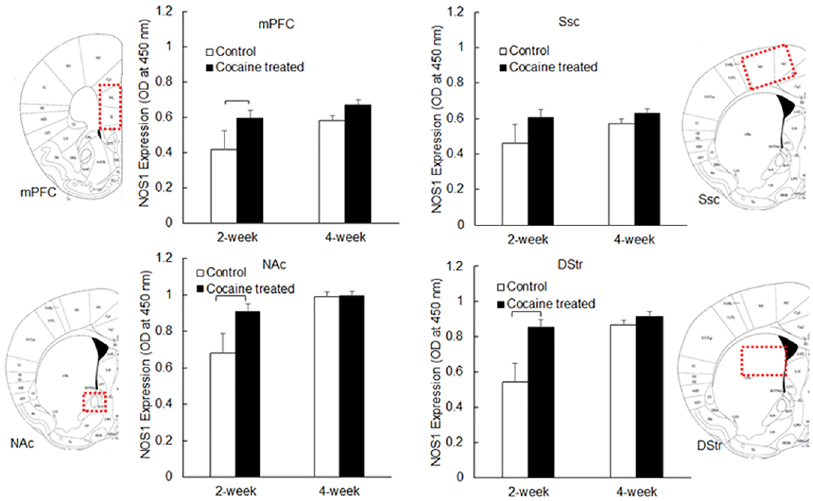
Fig 2. NOS1 expression in rat brain tissue, following 2-week or 4-week cocaine treatment. Data is presented as mean + standarderror (n = 3–6). Two-way ANOVA was used to detect significantdifference betweentreatment groups. All significantdifferences ( P < 0.05)are